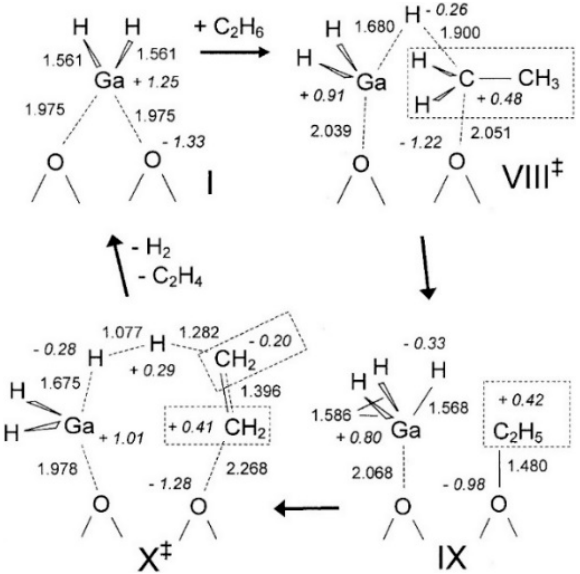
Figure 11. Regeneration of the adsorbed gallyl ion after “carbenium” activation of ethane. Re- printed with permission from ref [117]. Copyright 2000 American Chemical Society.